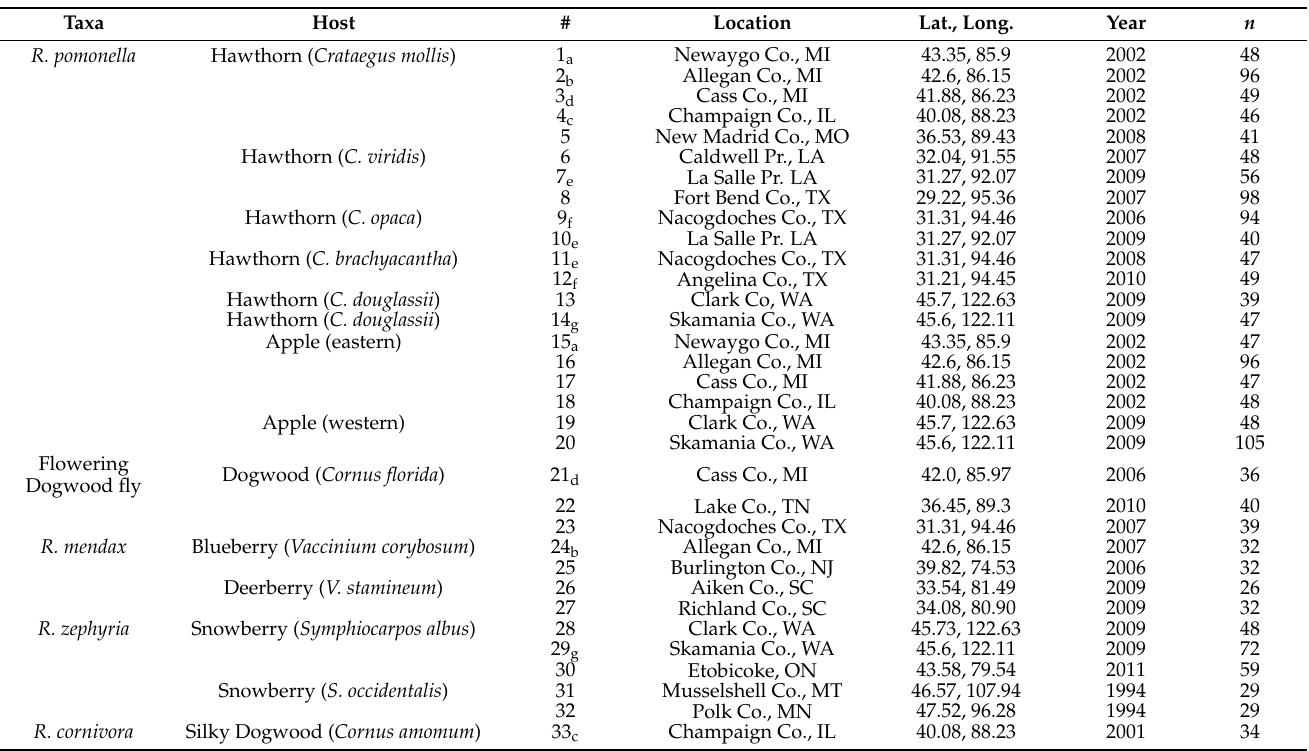
Table 1. Host plant origin, numerical designation, location, latitude [N] and longitude [W] in degrees, year sampled, and number of individuals genotyped ( n ). Subscript letters in the population number column designate sympatric